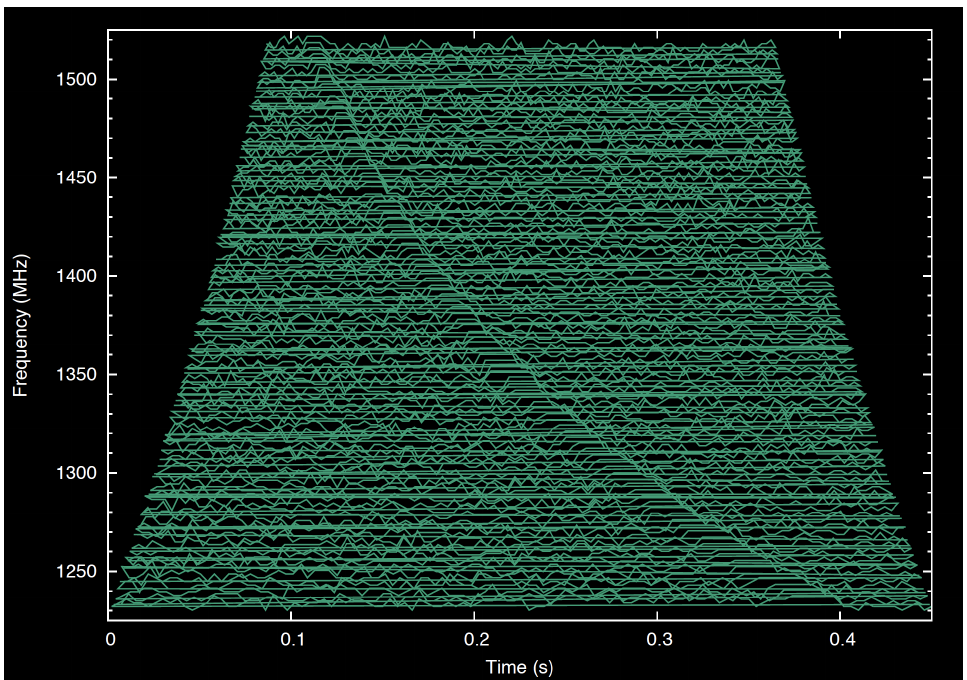
Figure 1. Time versus frequency plot aka the ‘dynamic spectrum’ of the main-beam detection (beam 6 of the Parkes multibeam receiver) of the ‘Lorimer Burst’Lorimer et al. [14]. The frequency-dependent delay in arrival time of the signal due to the column density of free electrons in the propagation path, called dispersion measure, is shown by the quadratic sweep. The saturation of the receiver for this beam is evident by the flat-topped signal across thhe band. The flux density of this burst was ∼ 30 Jy. with a DM of 375 pc cm − 3 . Only one eighth of this DM is accounted for, in this direction, by the Milky Way, suggesting an extragalactic